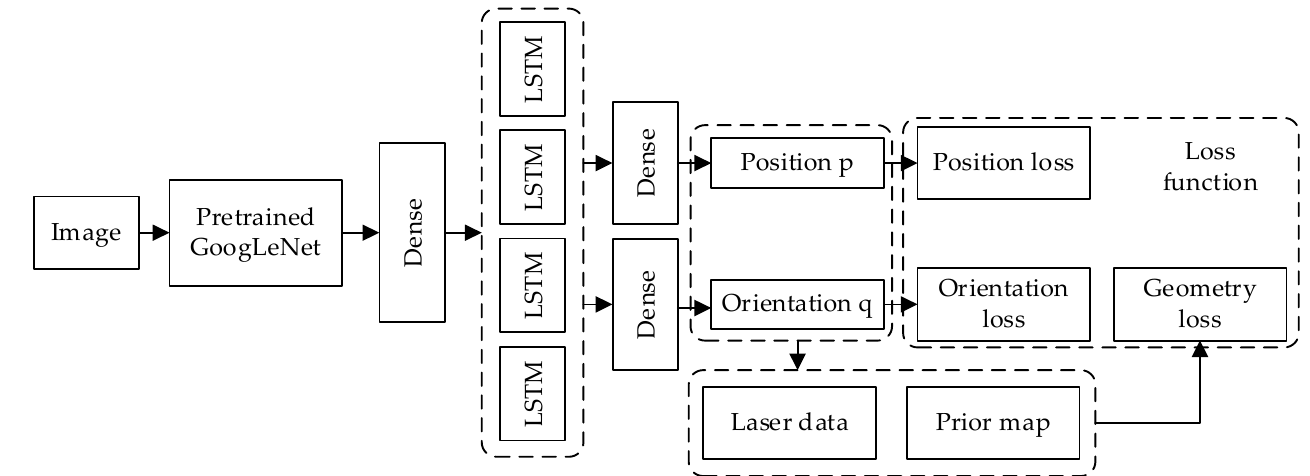
Figure 2. Convolutional neural network structure.